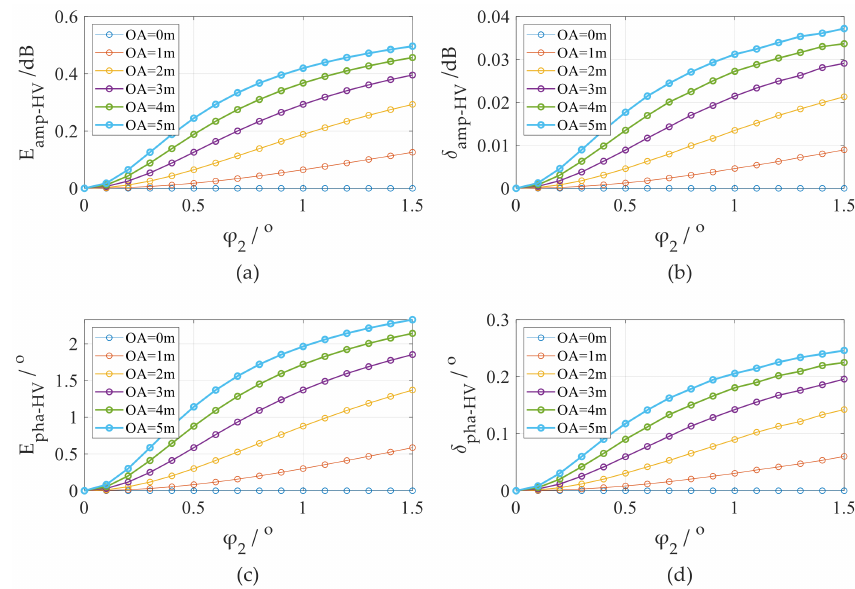
Figure 5. The effects of beam alignment errors on the calibration precision of the cross-polarization channel (HV). ( a ) Expectation of amplitude errors; ( b ) standard deviation of amplitude errors; ( c ) expectation of phase errors; ( d ) standard deviation of phase